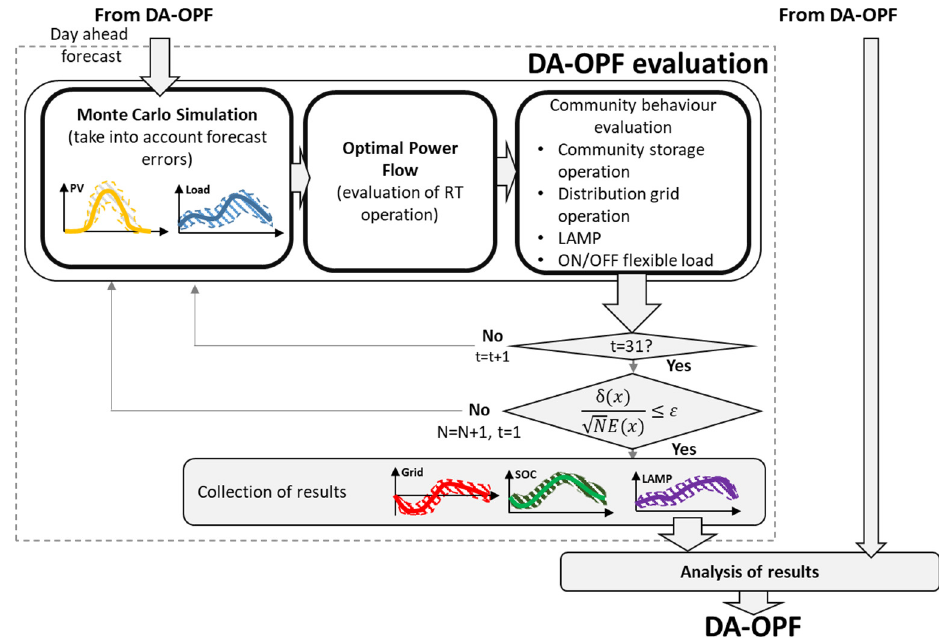
Figure 2. The flowchart of the developed SCM operation method—DA-OPF evaluation and analysis of results.